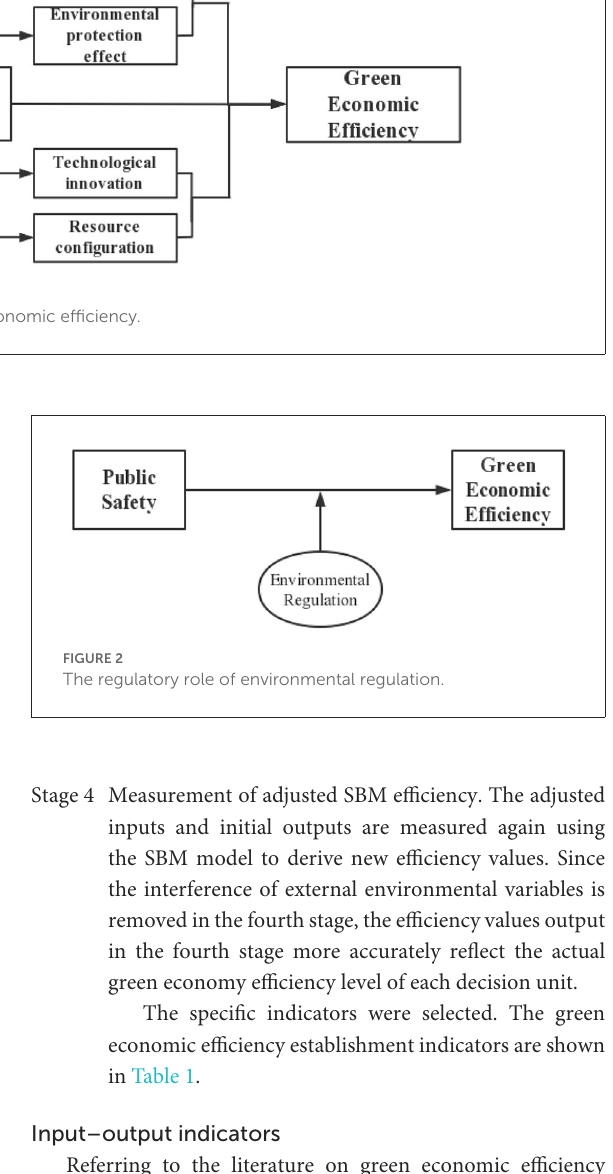
Stage 4 Measurement of adjusted SBM efficiency. The